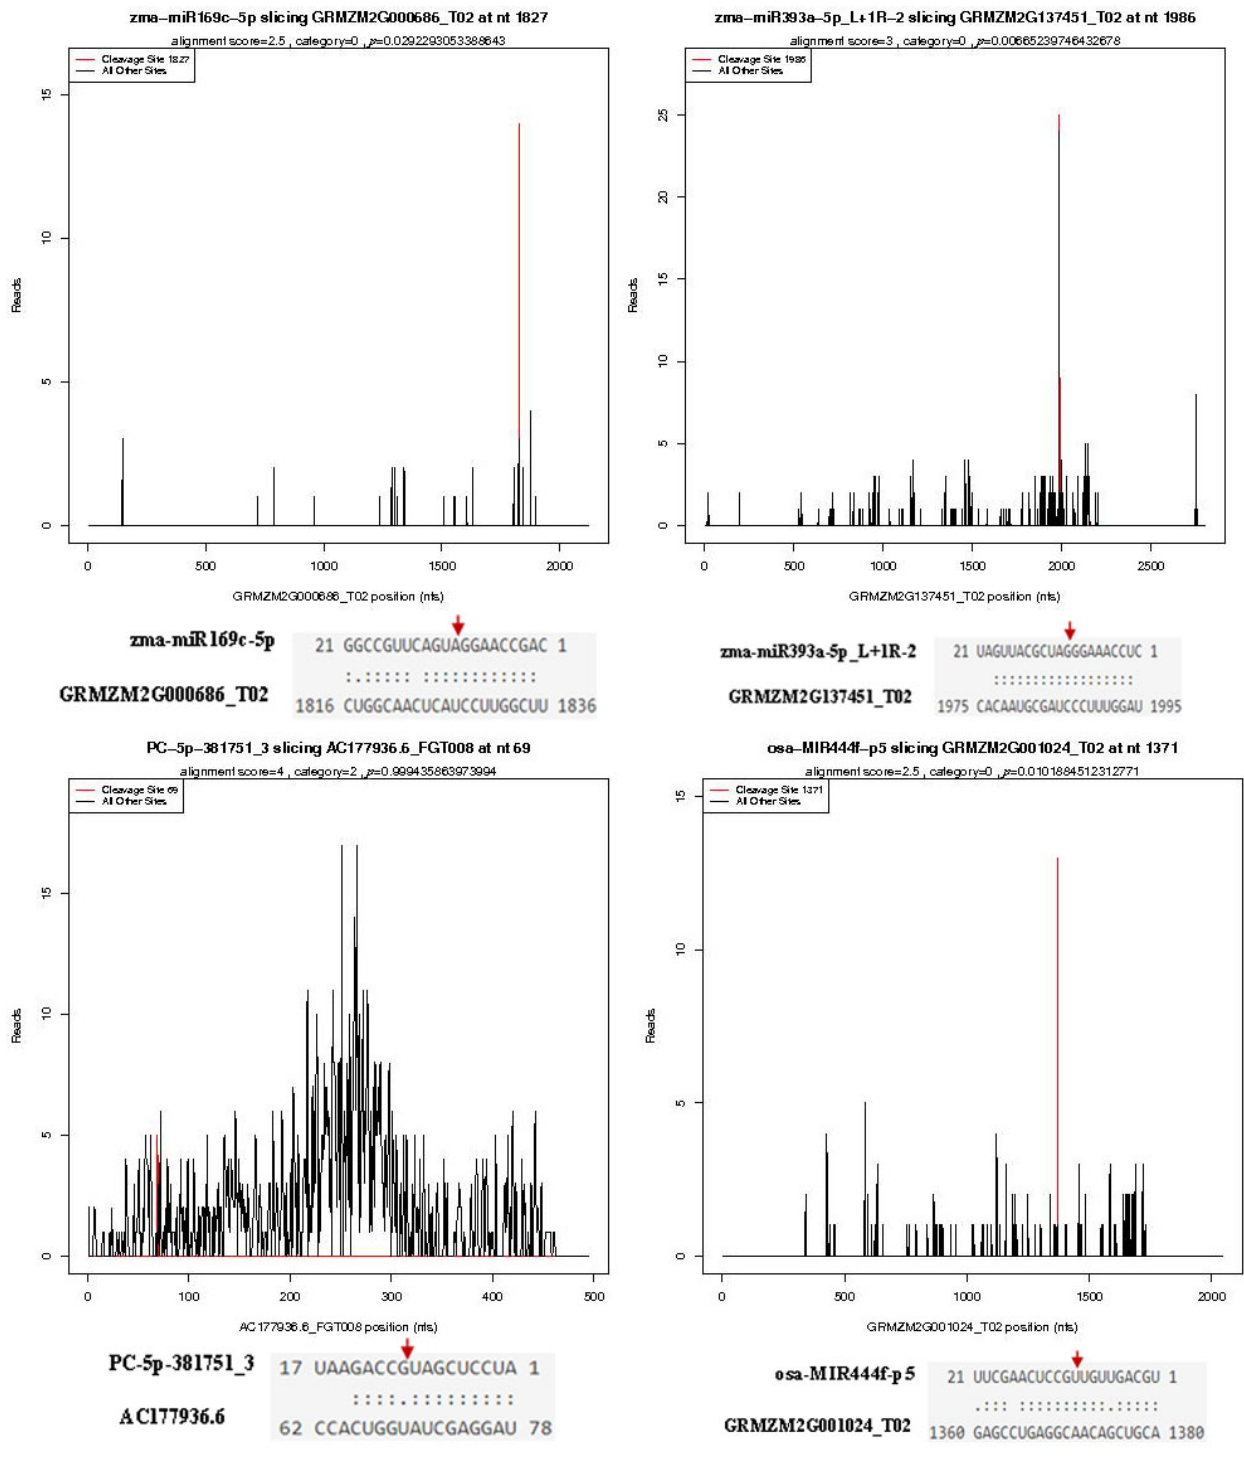
Figure 4. T-plot of miRNAs and their corresponding target genes. The red arrows indicate the splicing sites of the target gene to miRNA.